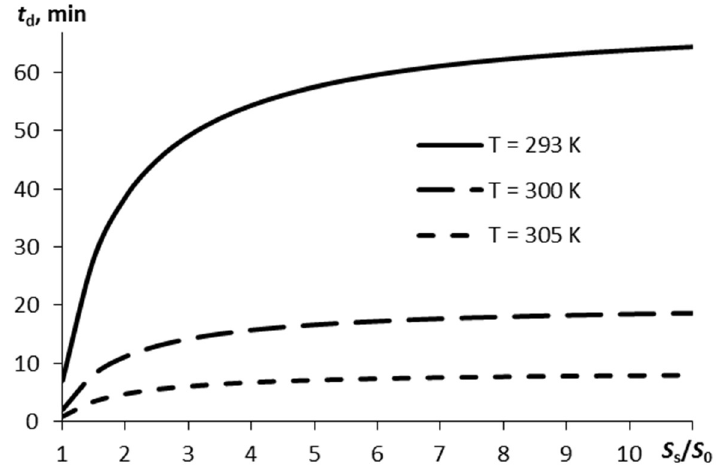
Figure 3. The time the vapor mass reaches ∆ m d = 0.1 ng in the air on sublimation of the thin RDX layer as a function of the ratio of the substrate surface area to the explosive layer surface area for three different temperatures.